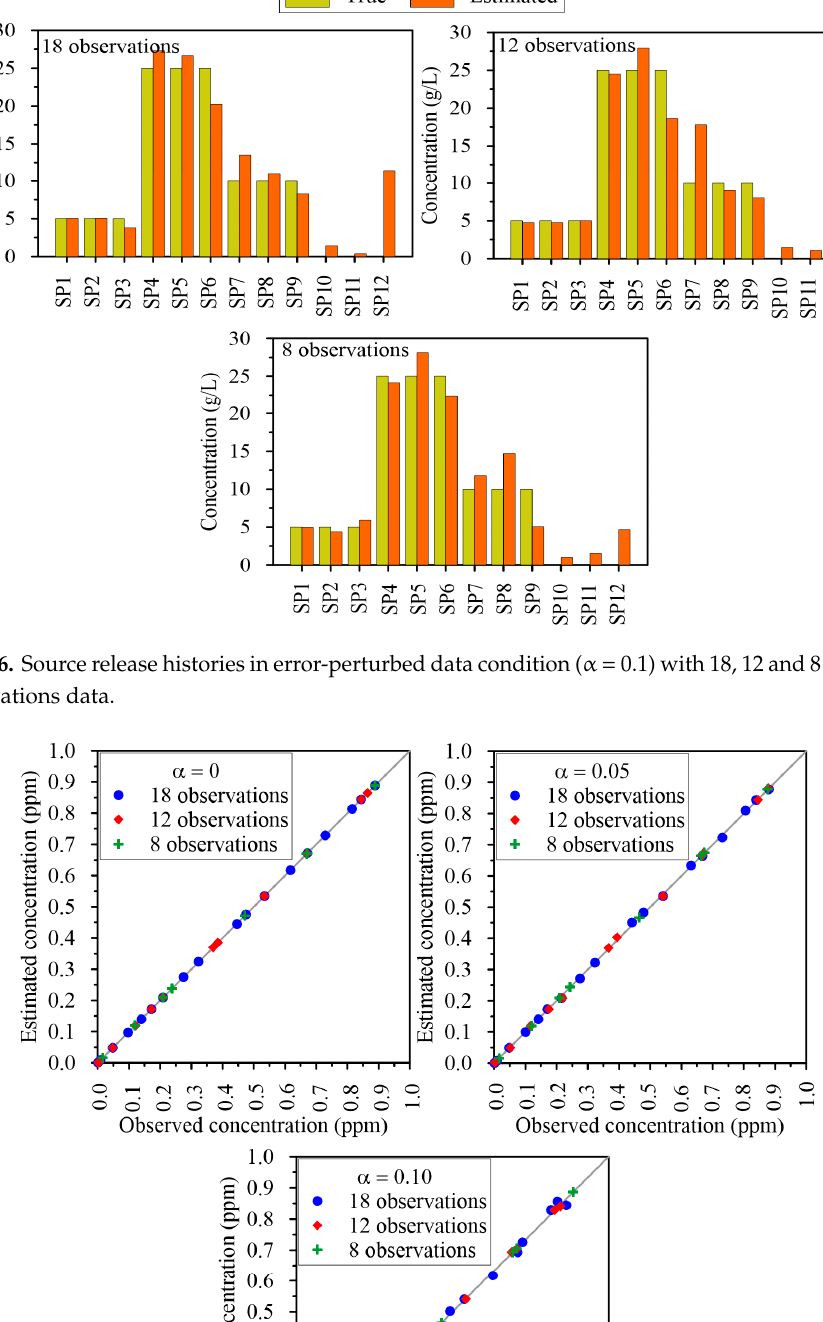
Figure 15. Source release histories in error-perturbed data condition ( α = 0.05) concentration with 18, 12 and 8 observed concentrations data.